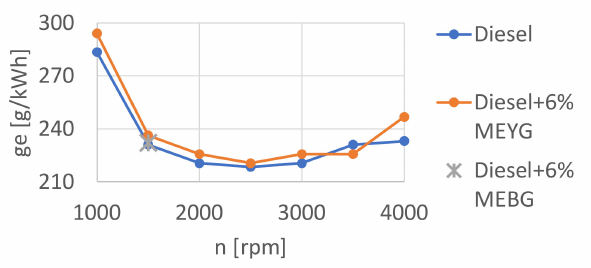
Figure 8. The fuel consumption g e at full engine load.